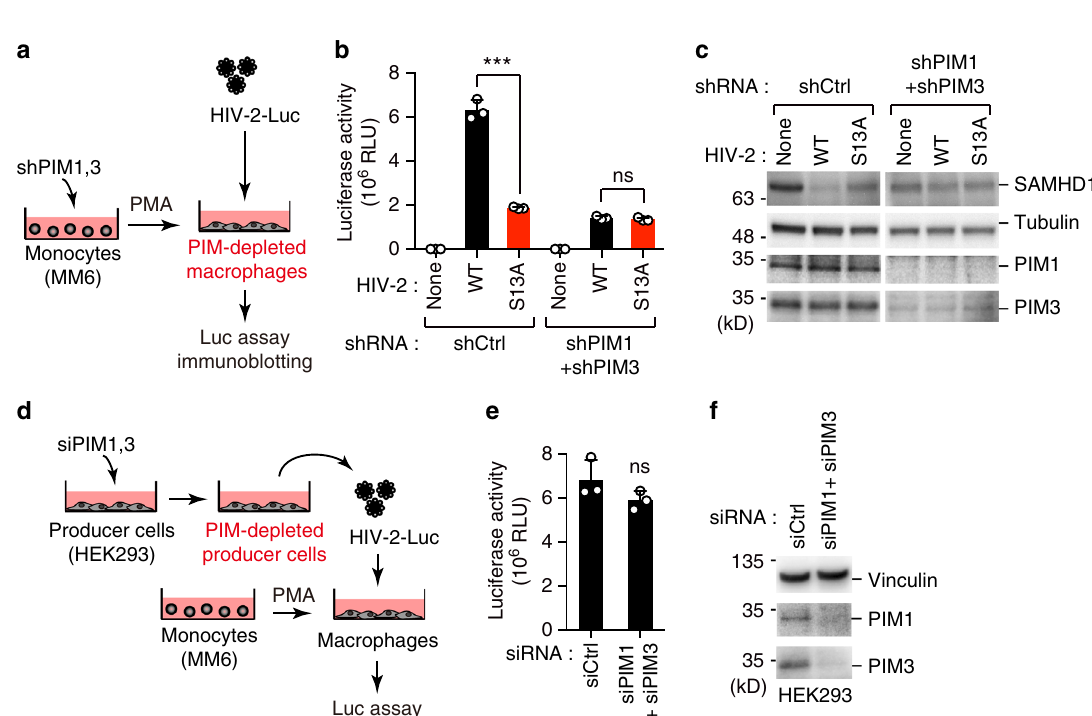
Fig. 5 Depletion of PIM kinases attenuates anti-SAMHD1 activity of Vpx. a – c Knockdown of PIM1 and PIM3 results in reduced viral replication. Schematic representation of the experimental system ( a ). Monomac6 (MM6) cells were stably transduced with shRNAs targeting PIM1 and PIM3. Cells were then differentiated into macrophages and infected with HIV-2 luciferase (Luc) reporter virus. Forty-eight hours later, the cells were harvested and subjected to luciferase assay ( b ) and immunoblotting ( c ) to measure HIV-2 infectivity and SAMHD1 expression, respectively. d – f Knockdown of PIM1 and PIM3 in producer cells does not affect late stage of virus replication cycle. Schematic representation of the experimental procedure ( d ). HEK293 cells were treated with either control or PIM-targeted siRNA for 24 h before transfection with an HIV-2 molecular clone. After 48 h, virus-containing culture supernatants were harvested. Equal amounts of HIV-2 were then used to infect Monomac6-derived macrophages. Forty-eight hours later, cells were subjected to luciferase assay to measure HIV-2 infectivity ( e ). Expressions of PIM1 and PIM3 in HEK293 producer cells are also shown ( f ). All graphs are presented as a mean ± s.d. ( n = 3). *** P < 0.001; ns, not signi fi cant, two-tailed unpaired t-test. Source data are provided as a Source Data fi